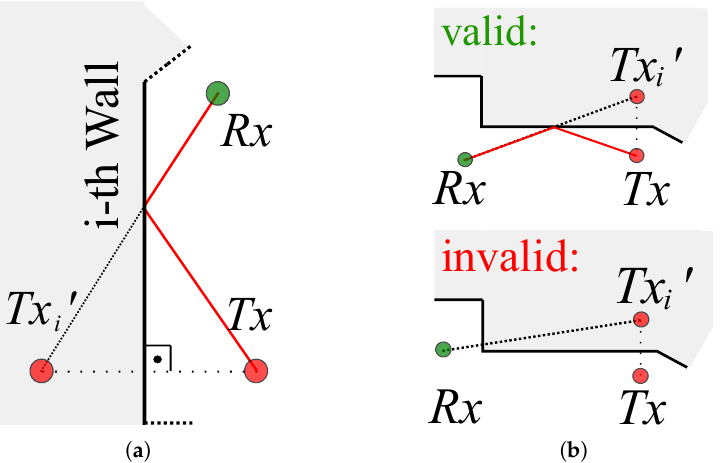
Figure 6. Modeling of raytracing. ( a ) Determination of the i -th virtual node Tx (cid:48) echo